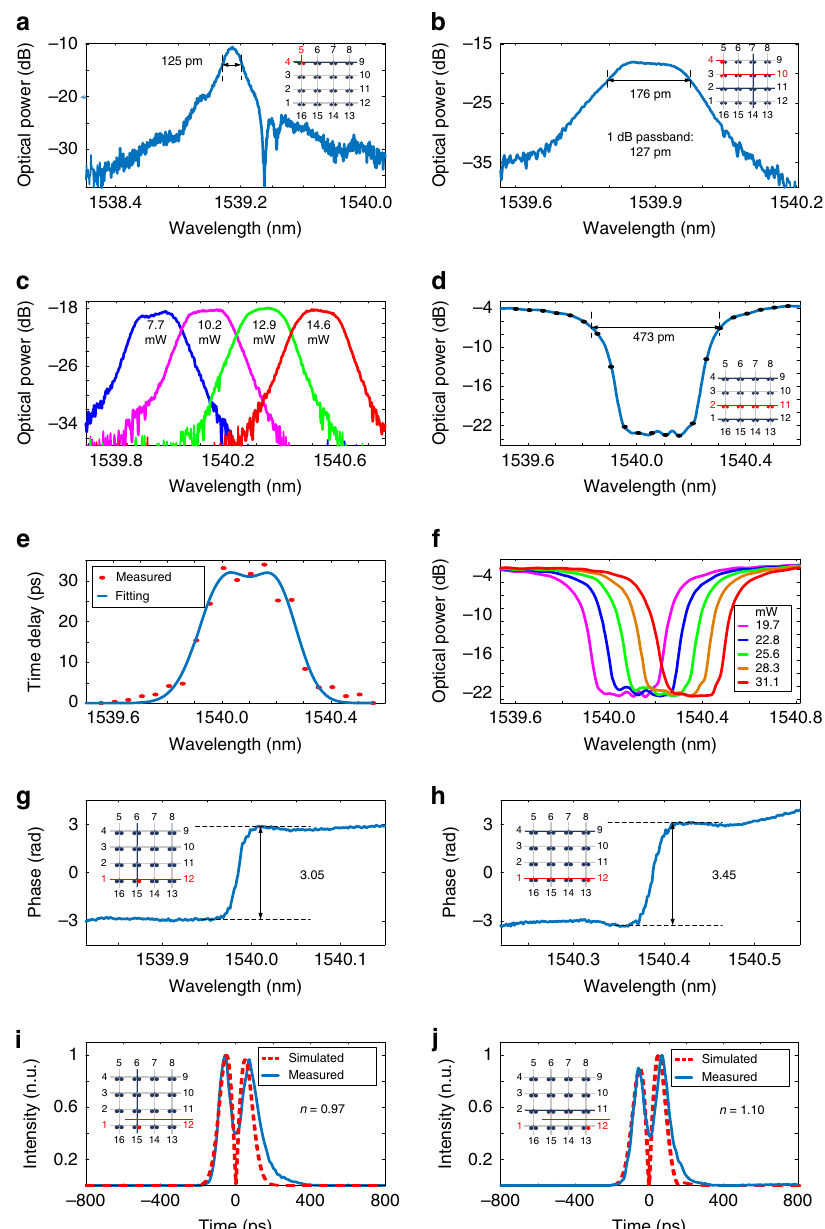
Fig. 3 Experimental results with FPDA recon fi gured to perform multiple functions. a Measured transmission spectrum at port 5 when an optical signal is applied to the chip via port 4. b Measured transmission spectrum at port 10 when the FPDA operates as a fl at-top optical fi lter. c Center-frequency tuning of the fl at-top optical fi lter. d Measured transmission spectrum at port 11 when an optical signal is applied to the chip via port 2. e Measured group delay. f Center-frequency tuning of the delay line. g Measured phase response of the 3rd MDR from the left in the channel from port 1 to port 12. h Measured phase response of the 8th MDR. i Measured differentiated Gaussian pulse when the 3rd MDR works as a temporal differentiator. j Measured differentiated Gaussian pulse when the 8th MDR works as a temporal